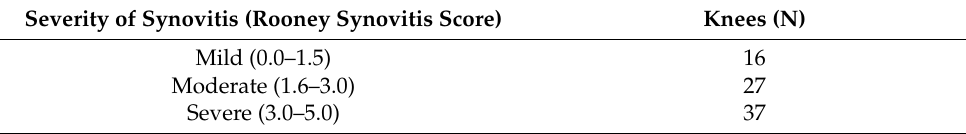
Table 2. Inflammatory arthritis patients classified on the basis of severity of synovitis.